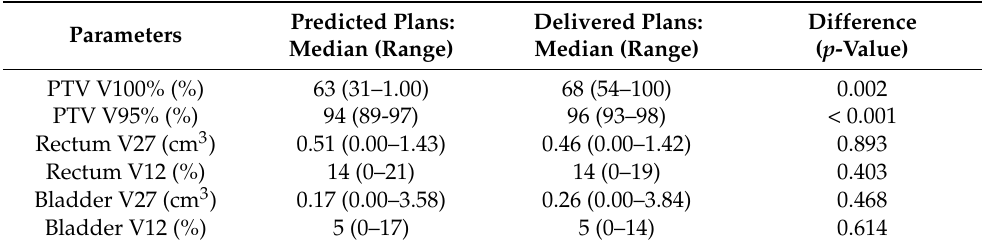
Table 3. Comparison of dosimetric parameters between predicted and delivered plans for patients with plan